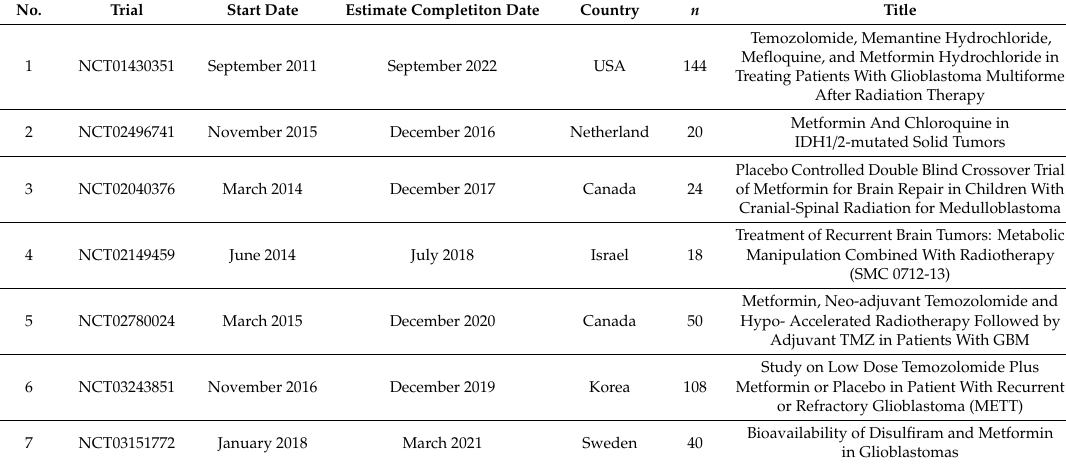
Table 1. Currently registered clinical trials considering the use of metformin in glioma and cerebral tumors